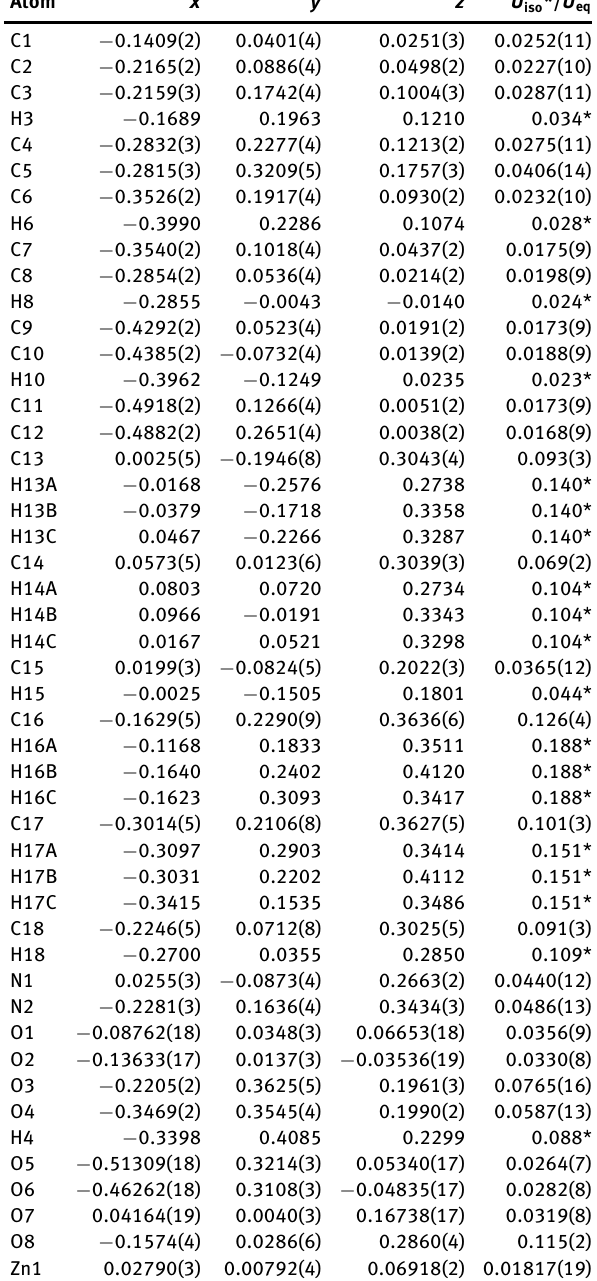
Table 2: Fractional atomic coordinates and isotropic or equivalent isotropic displacement parameters (Å 2